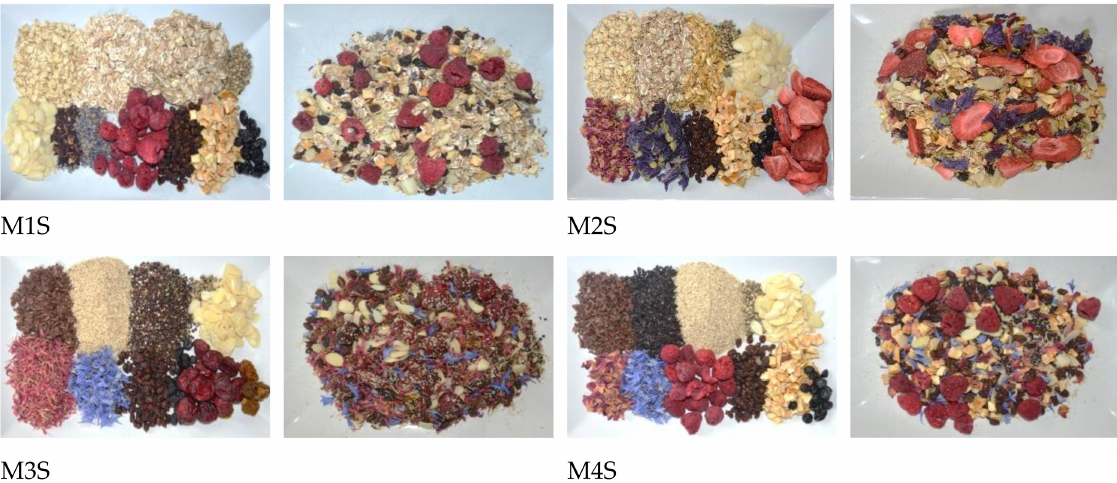
Figure 1. Non-traditional nutraceutical mixtures with edible flowers according to recipe presented in Table